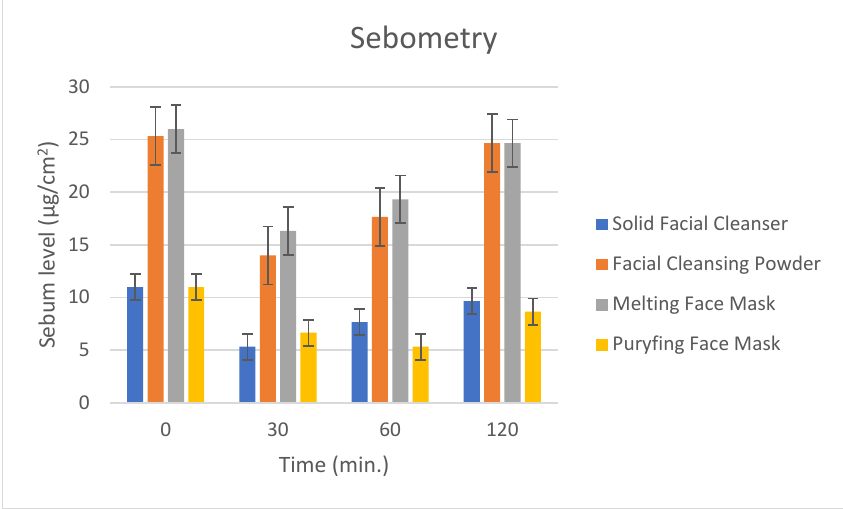
Figure 10. Skin sebum measurement before the application of the cosmetic products, and after 30, 60 and 120 min after the removal of that.